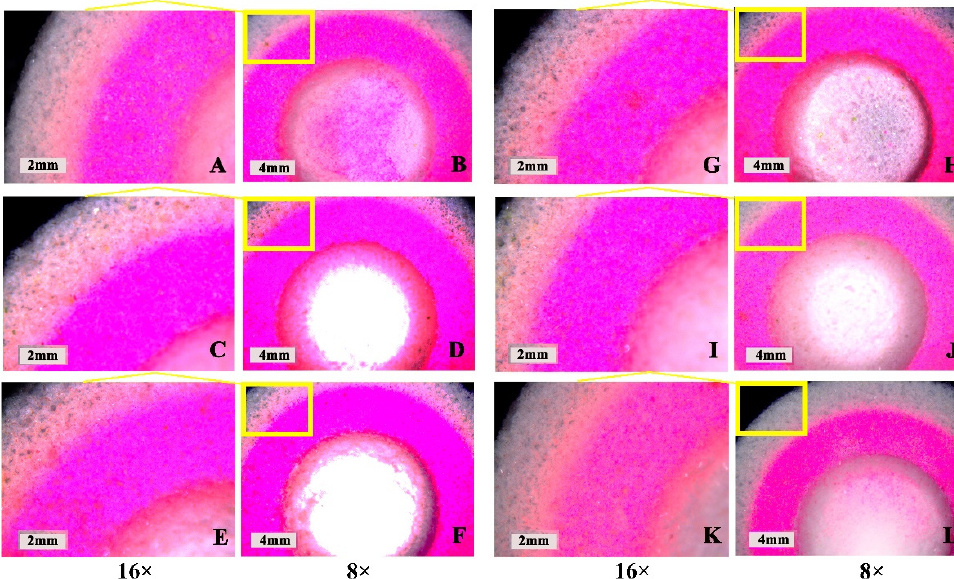
Figure 6. Influence of drying parameters on the “coffee ring” effect of the 3D-printed compound multicompartmental dispersible tablet. ( A , B ): Ordinary drying at 30 °C; ( C , D ): Ordinary drying at 40 °C; ( E , F ): Ordinary drying at 60 °C; ( G , H ): Ordinary embedding drying at 40 °C; ( I , J ): Vacuum drying at 40 °C; ( K , L ): Vacuum embedding drying at 40 °C.